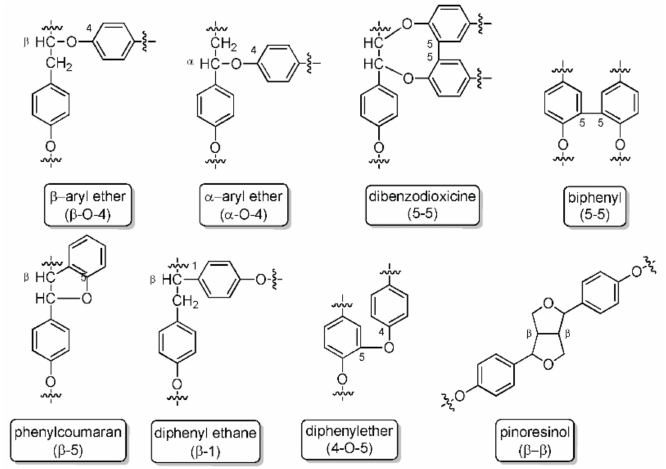
Figure 2. Lignin linkages: ether bonds, carbon-carbon bonds, and more complex